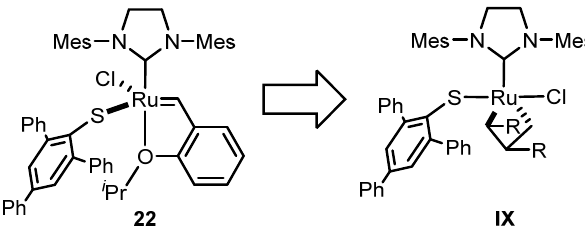
Figure 6. Model of 22 ’s mode of selectivity by shielding one side of the ruthenacycle. Table 9. Homodimerization of olefins employing 22 and 24 .